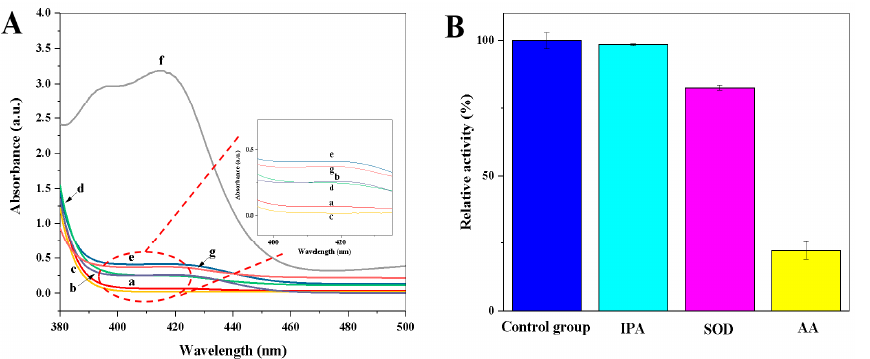
Figure 3. ( A ) UV–Vis absorption spectra of (a) CuCl 2 · 2H 2 O solution, (b) K 3 [Fe(CN) 6 ] solution, (c) ABTS solution, (d) CuCl 2 · 2H 2 O + ABTS mixture solution, (e) K 3 [Fe(CN) 6 ] + ABTS mixture solution, (f) CuCl 2 · 2H 2 O + K 3 [Fe(CN) 6 ] + ABTS mixture solution, (g) CuCl 2 · 2H 2 O + K 4 [Fe(CN) 6 ] + ABTS mix- ture solution; ( B ) The relative activity (%) of copper hexacyanoferrate nanoparticles in the presence